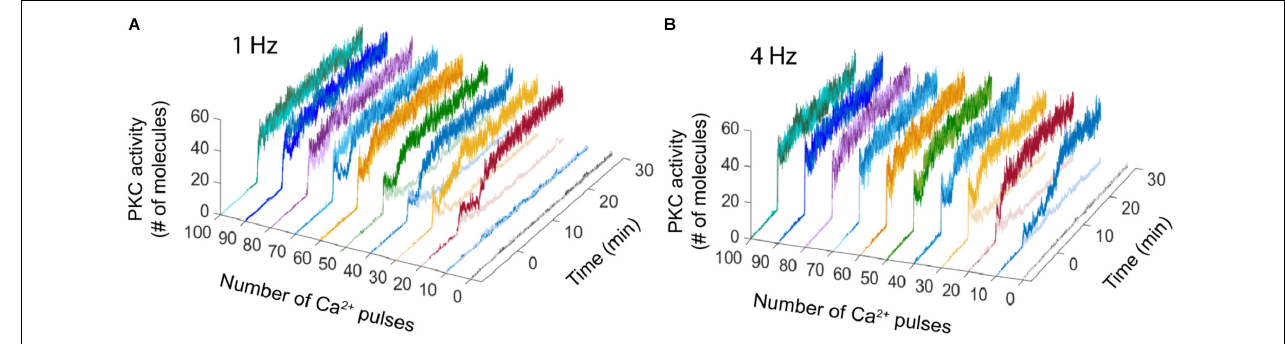
FIGURE 3 | PKC activity over time shows bistability. Raw data of PKC over time in the LTD signaling network at different number of Ca 2 + pulses. Two different trials were chosen randomly for every number of Ca 2 + input. (A) Bistability of PKC activity is clearly visible from 20 to 50 calcium pulses at 1 Hz and (B) from 10 to 30 pulses at 4